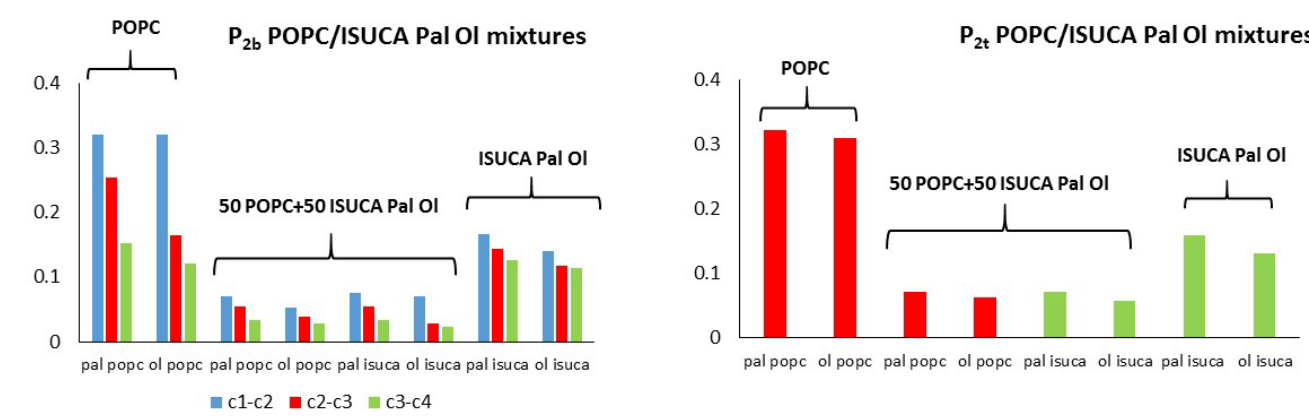
Figure 8. P 2t and P 2b for POPC/ISUCA-Pal Ol mixtures.